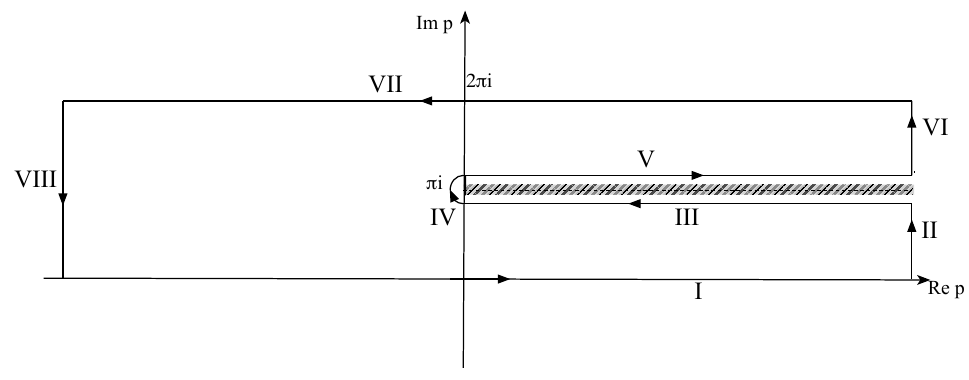
Figure 2 . Contour in the complex p-plane used to perform the shift p → p + 2 πi